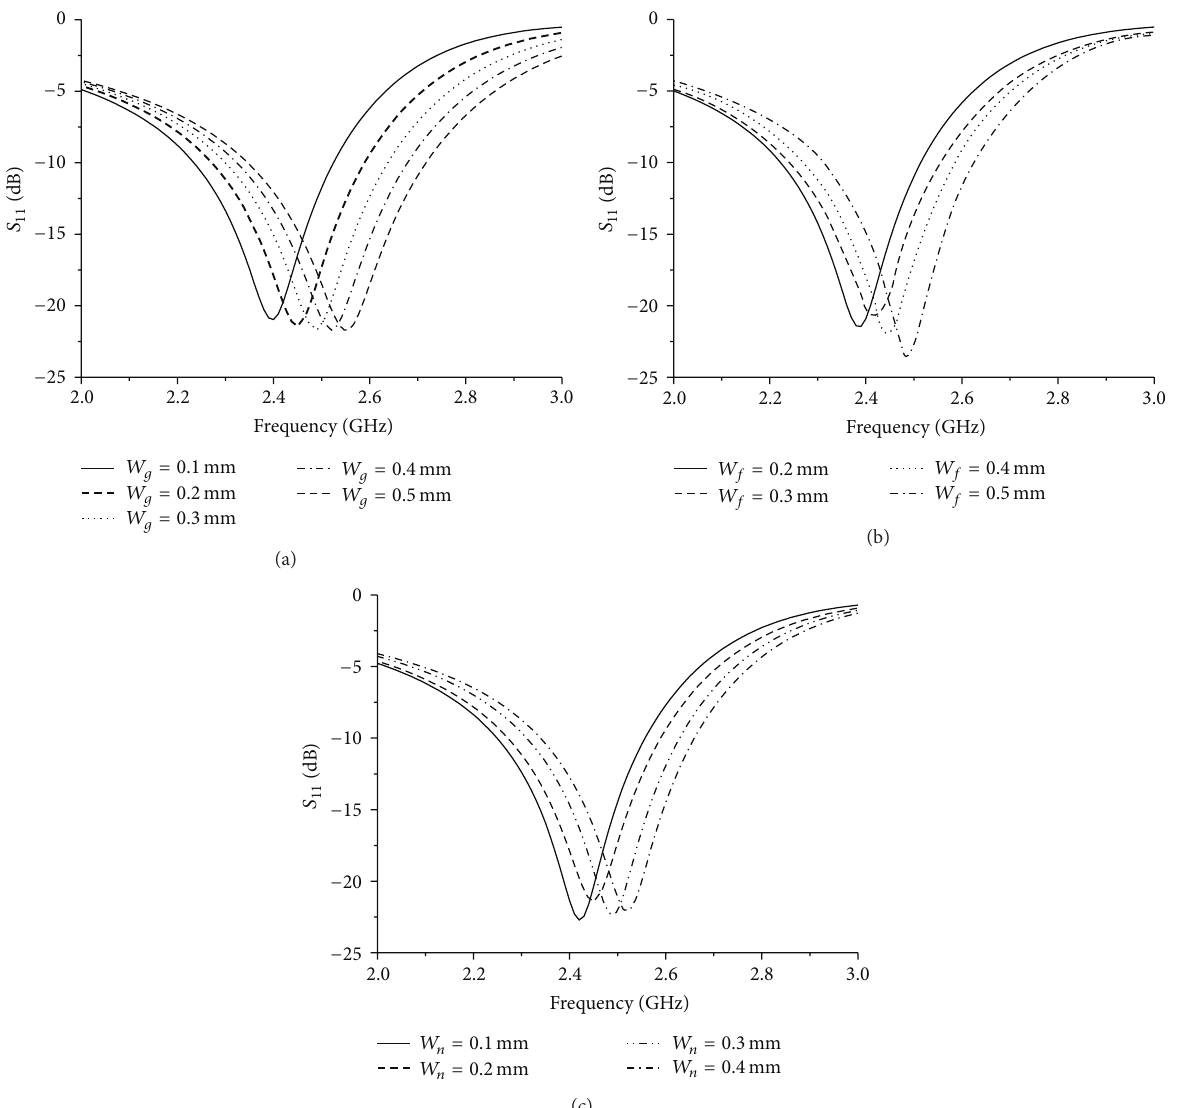
Figure 3: Simulated reflection coefficients as a function of (a) 𝑊 𝑔 , (b) 𝑊 𝑓 , and (c) 𝑊 𝑛 .